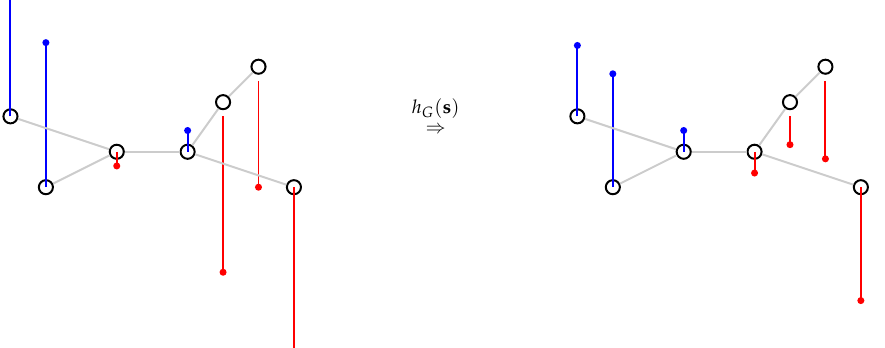
Figure 1. Illustrative example of the graph filter. The signal is represented by the blue(positive) and red(negative)